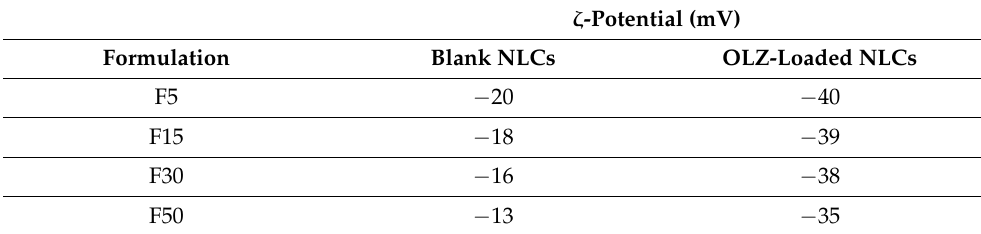
Table 4. Effect of solid to liquid lipid ratio on surface charge of blank and drug-loaded NLCs.